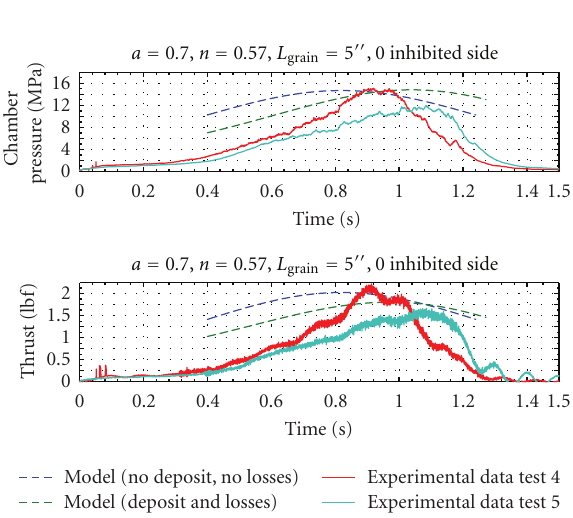
Figure 5: Comparison of 5 (cid:4)(cid:4) long ALICE motor tests with lumped parameter